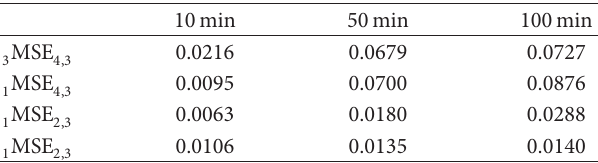
T 2: Mean square error between the curves of the availability applied to real and synthetic